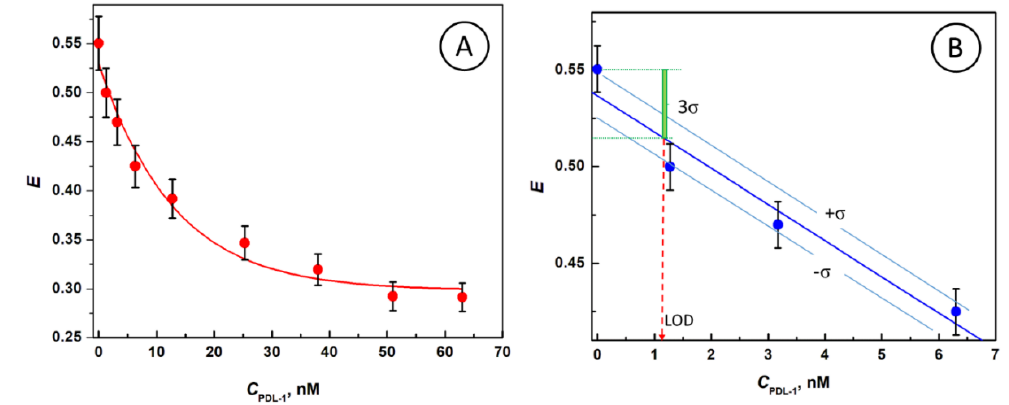
Figure 5. ( A ) Dependence of the gRET efficiency for energy transfer from FITC to AuNP@Cit on PD-L1 concentration showing saturation at higher PD-L1 concentrations. ( B ) Details of the limit of detection (LOD) determination using 3 σ method (LOD = 1.2 nM). FITC concentration: 66.7 nM, C AuNP@Cit = 2.02 nM, λ ex = 495 nm.